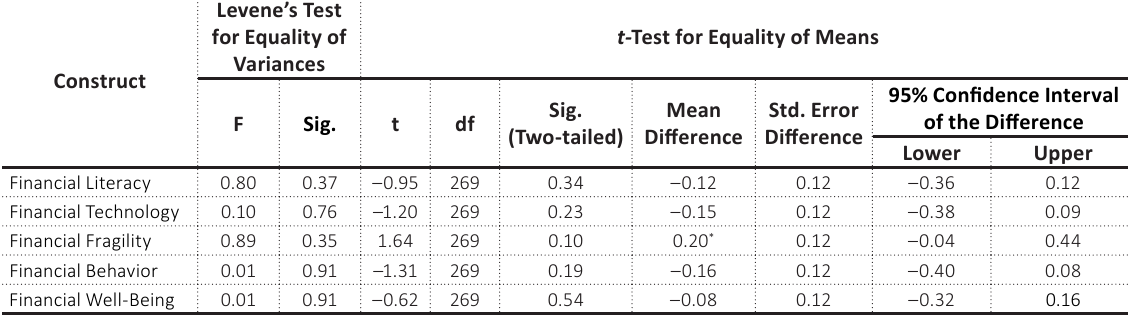
Table 10. Independent sample t -tests for financial well-being and its factors by age